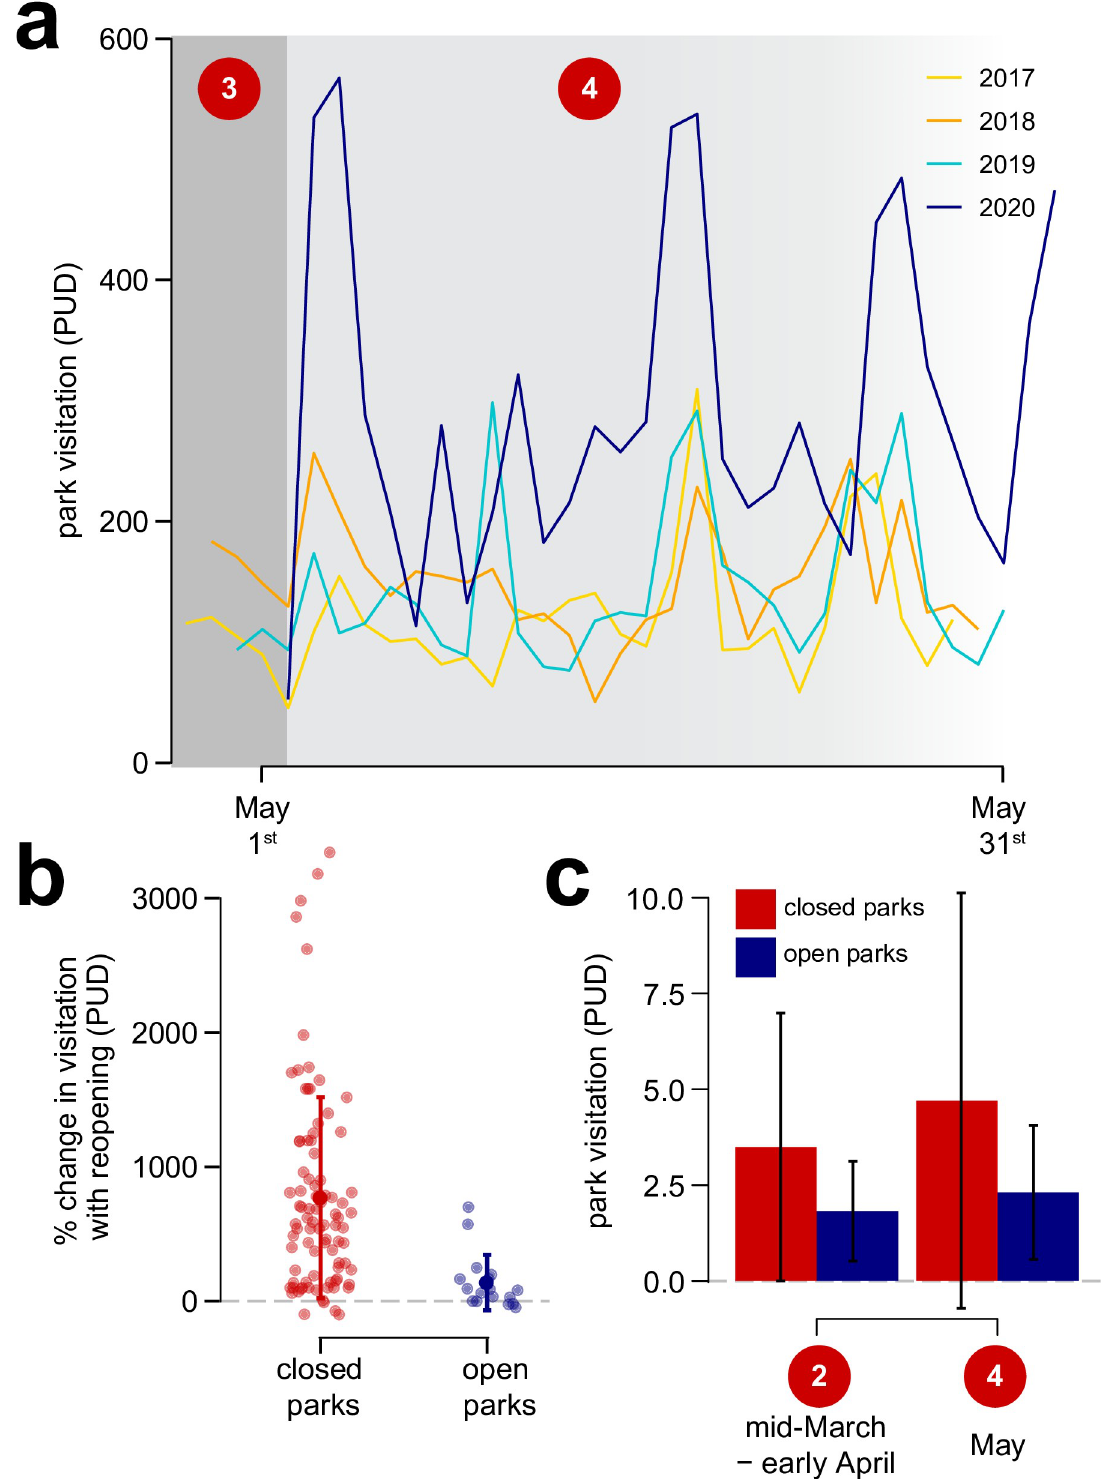
Fig 5. The effects of the lifting of the park shutdown order on park visitation. (a) Park usage during May 2020 was higher relative to previous years. (b) Increases in visitation were much larger in formerly closed parks as compared to parks that had remained open. However, (c) visitation did not exceed visitation levels from before the shutdown. The numbers in red circles in (a) and (c) refer to time periods denoted in Fig 1.